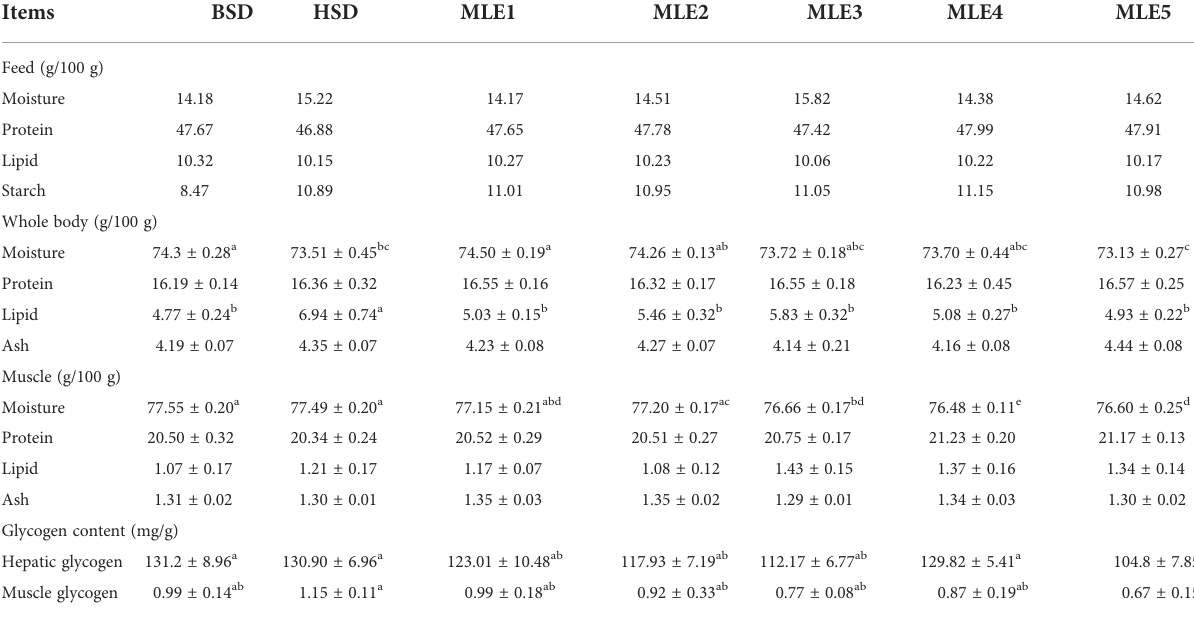
TABLE 3 Effects of mulberry leaf extract on experimental diets and proximate compositions of Micropterus salmoides fed high-starch diet diets.